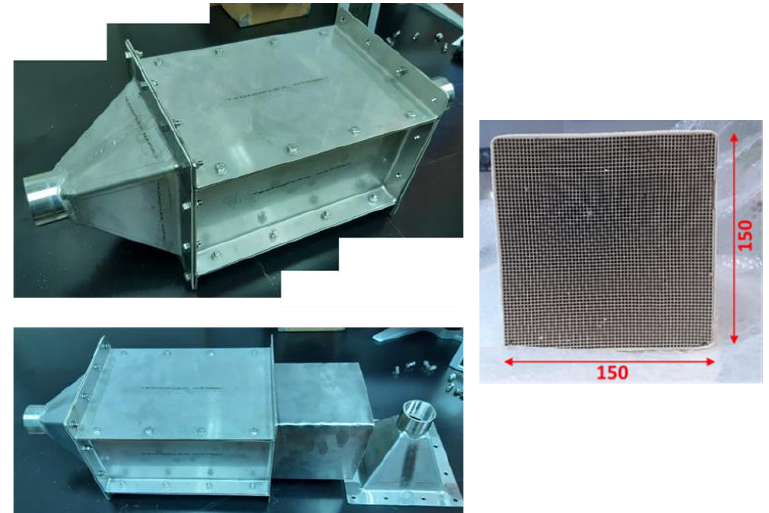
Figure 1. Box and